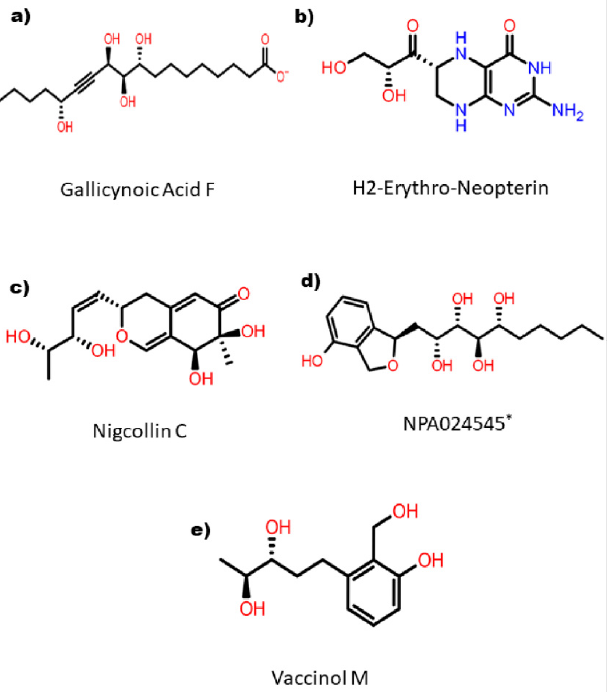
Figure 2. 2D representation of the selected top five hit compounds derived after series of screening methods implemented on natural compounds against MPXV proteinase. * Name of the compound is not